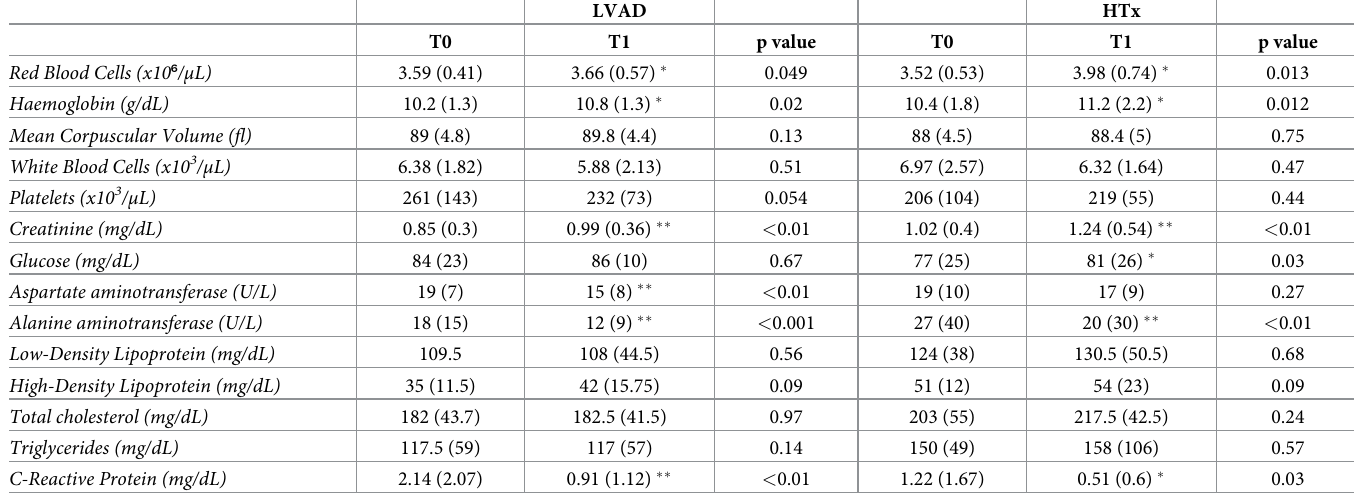
Table 1. Blood chemistry test at admission to (T0) and discharge from (T1) cardiac rehabilitation with the significance of the difference, separately in LVAD and HTx patients.